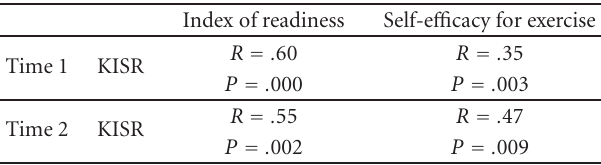
Table 2: Correlations of KISR with ESE and index of readiness for physical